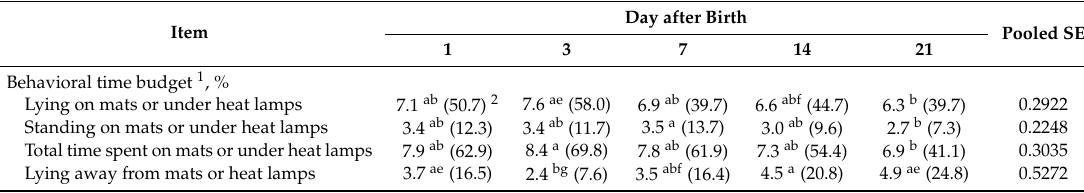
Table 2. Selected time budget for postures at di ff erent days of age (Trial 1).